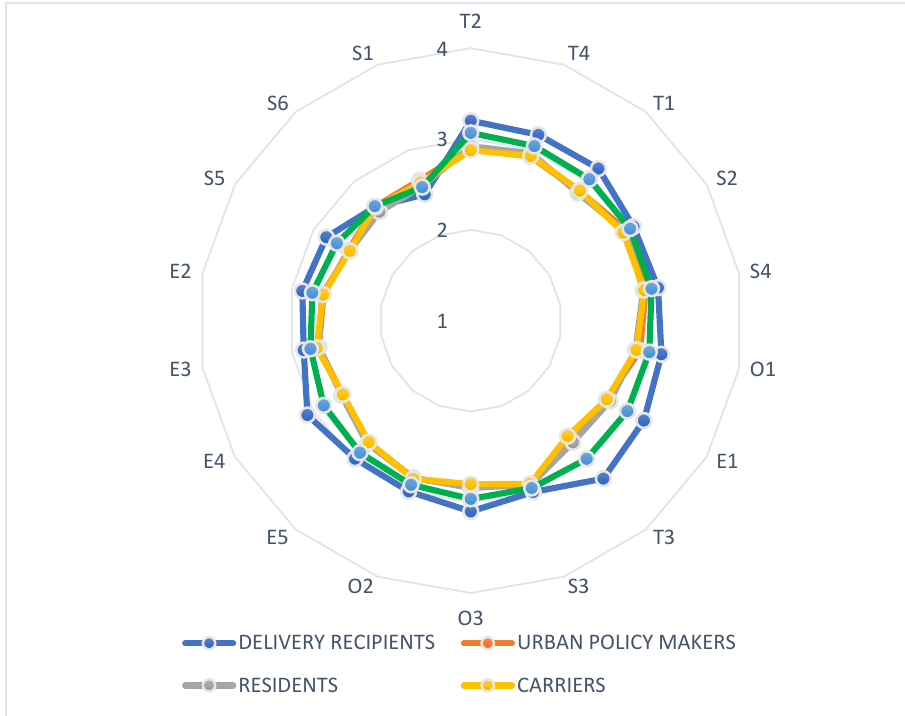
Figure 2. Average assessment of the relevance of the criteria according to all stakeholders. Source: authors.